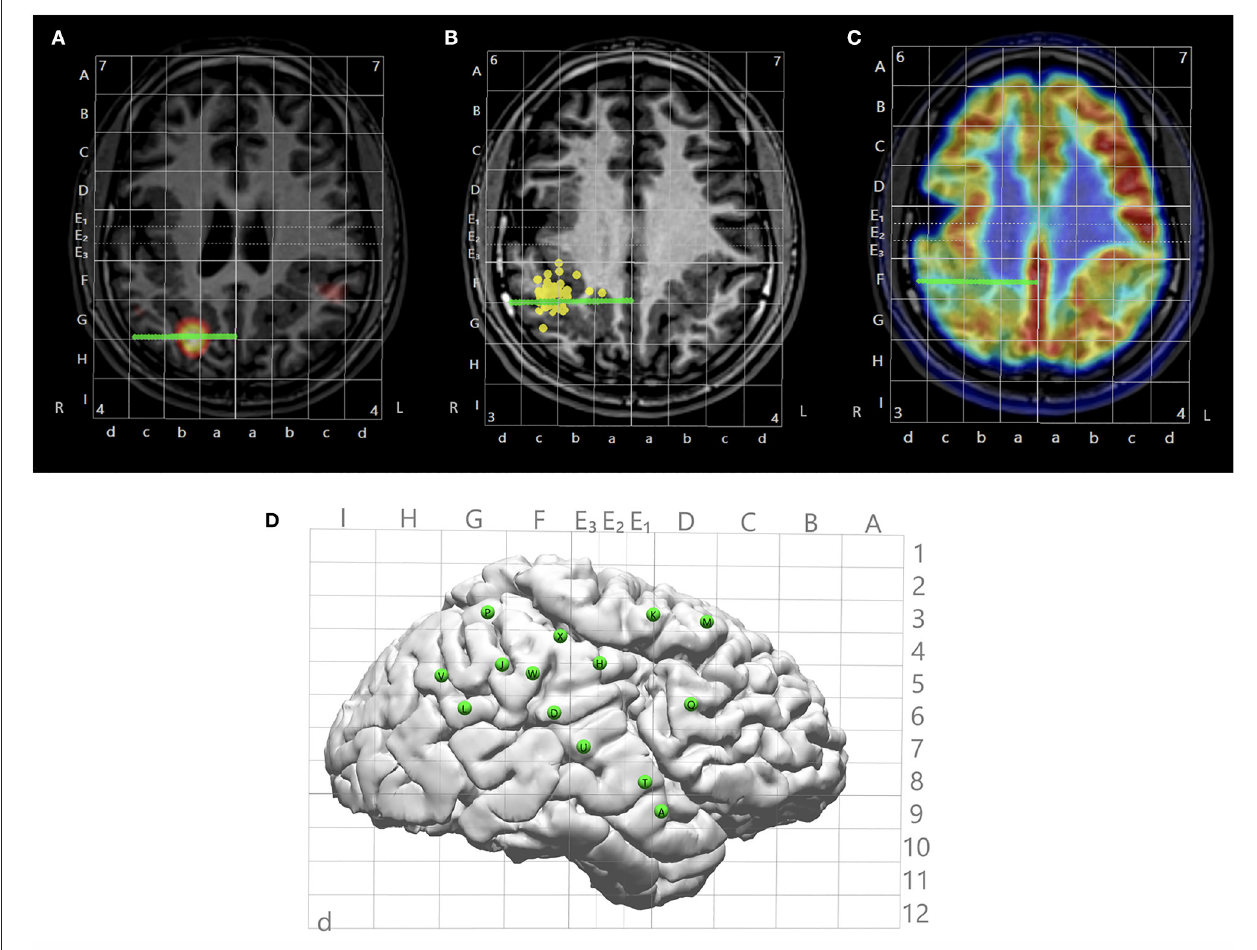
FIGURE 3 | Illustration of multimodal integration assisting trajectory planning. (A) A trajectory planned to target a hyperperfusion region shown by subtraction ictal SPECT co-registered with MRI (SISCOM) analysis. (B) A trajectory planned to target a tight MEG cluster. (C) A trajectory planned to target hypometabolic regions on the PET. (D) Entry points of all planned trajectories shown on the cortical surface with Talairach grid overlaid.